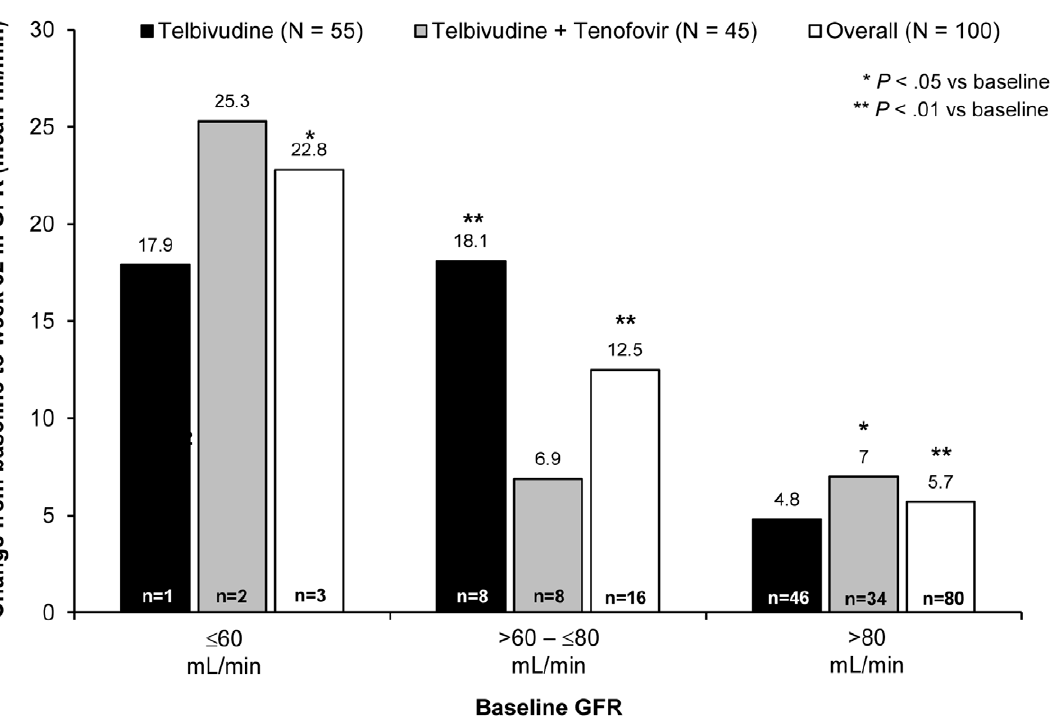
Figure 4. Week 52 glomerular filtration rate (MDRD) changes, by baseline rate and treatment (efficacy population).